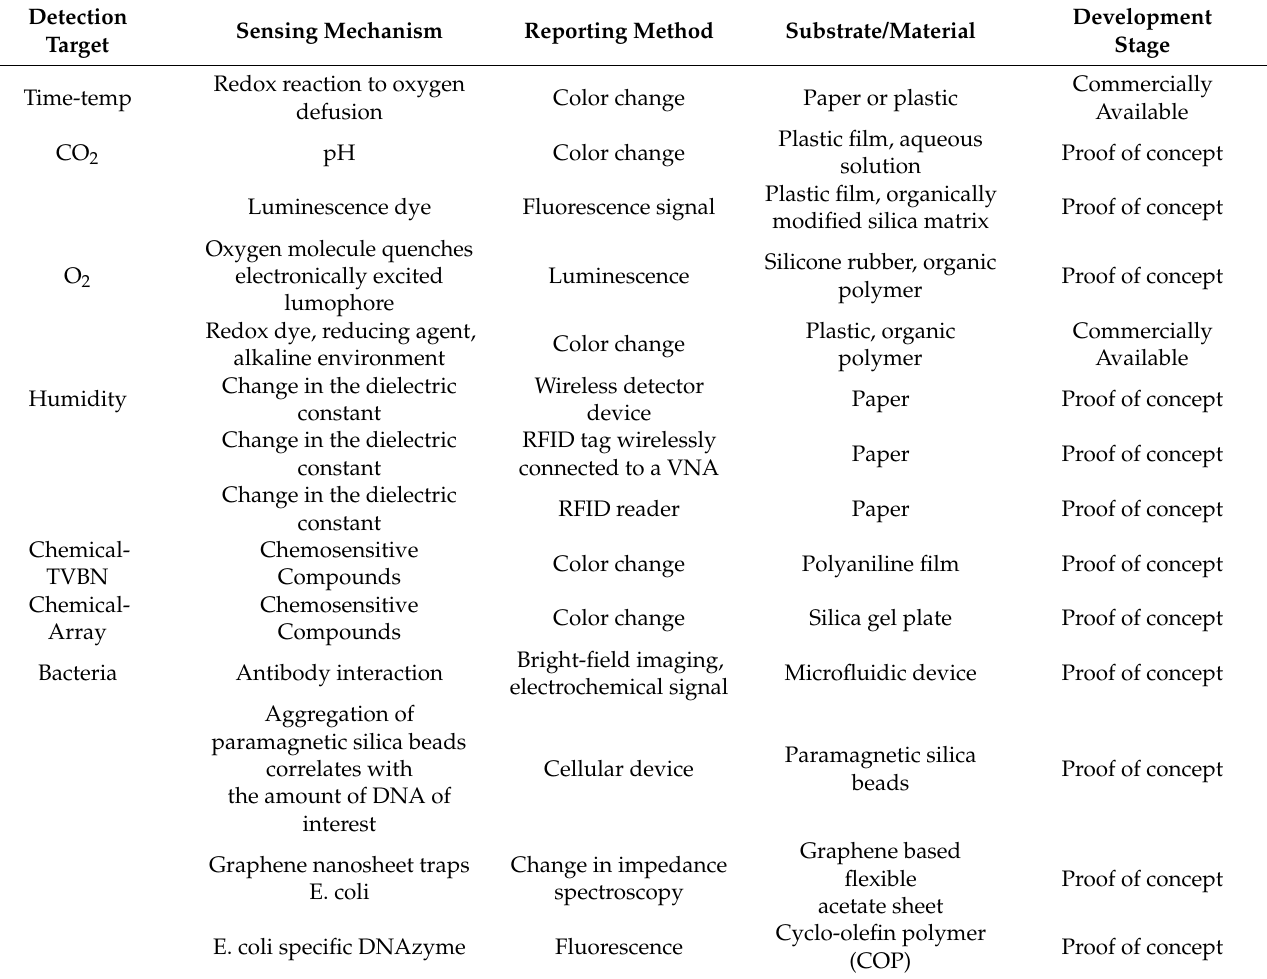
Table 3. Developed sensors for monitoring of packaged food quality. Based on Reference [48].